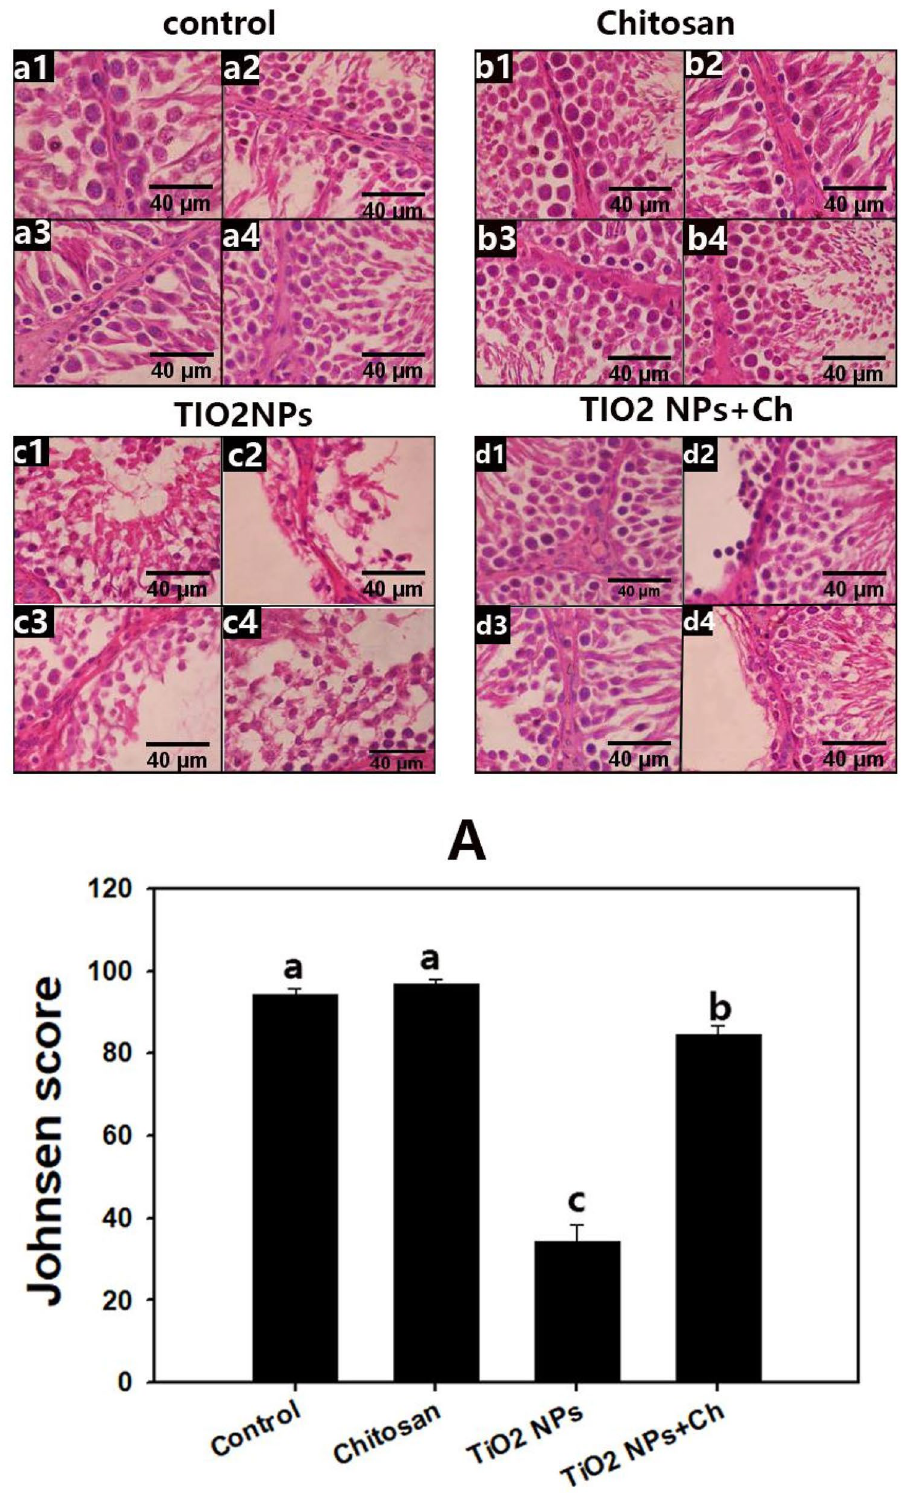
Figure 8. Photomicrograph of a section of rat’s testis stained with H&E showing Spermatogenesis assessment of experimental groups ( a1 – a4 ) control group, ( b1 – b4 ) chitosan group, ( c1 – c4 ) TIO 2 NPs and ( d1 – d4 ) TIO 2 NPs + Ch group. ( A ): Johnson scores of the experimental group, data are expressed as Mean ± SEM. The different letters indicate significant difference ( p < 0.05) between experimental